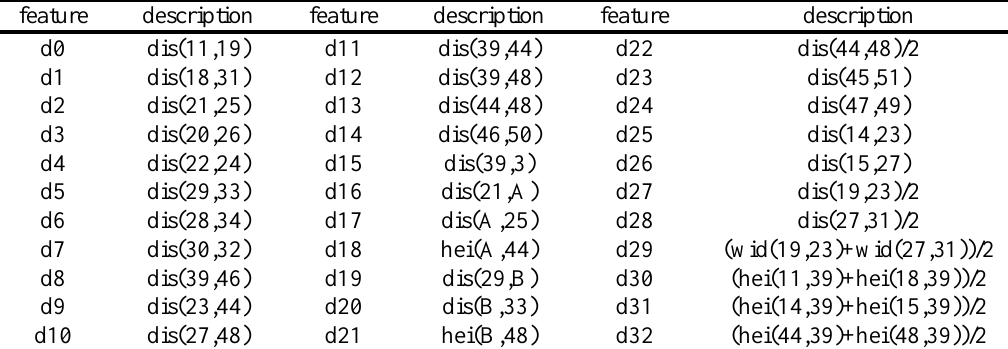
Table 2 33 features defined on 52 feature points